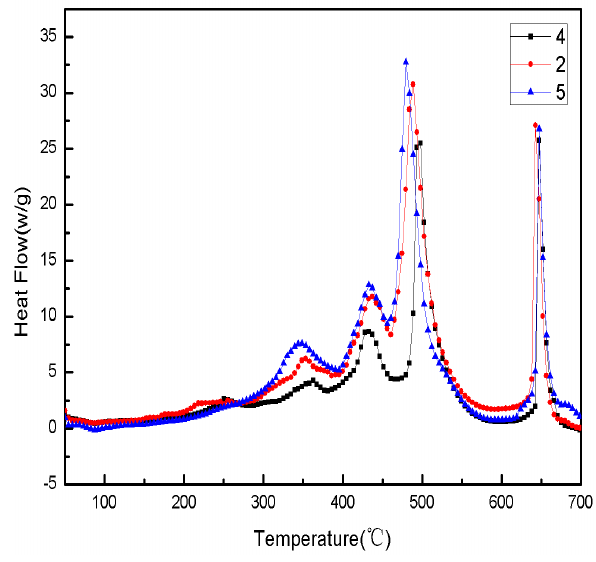
Figure 13. The DSC curves of paraffin-based